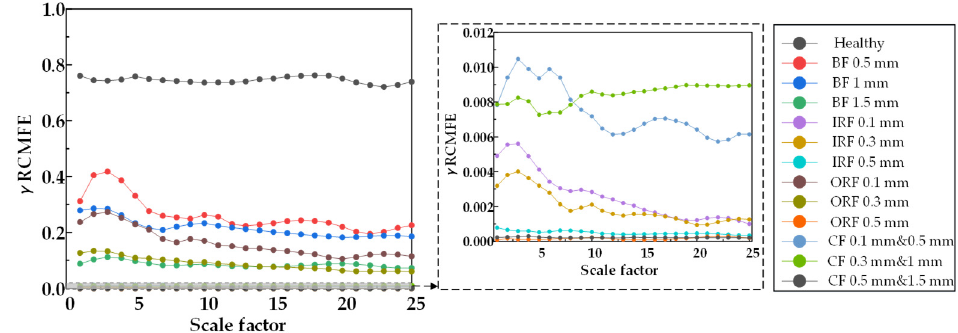
Figure 29. γ RCMSE entropy values of 25 scale factors under different damage degrees.